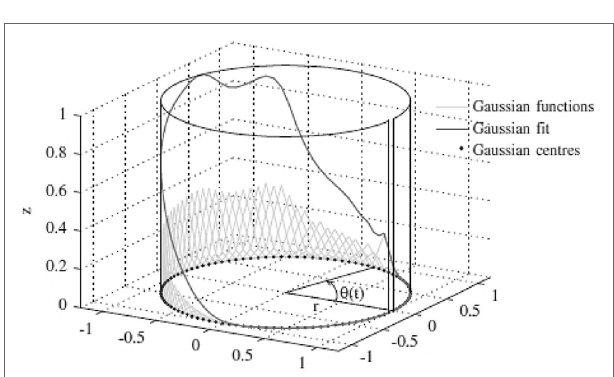
FiGURe 9 | Examples of different shapes of measured force traces due to jumping at 1.5, 2, and 2.5 Hz. Reprinted from (Racic and Pavic, 2010b) with permission from Elsevier.